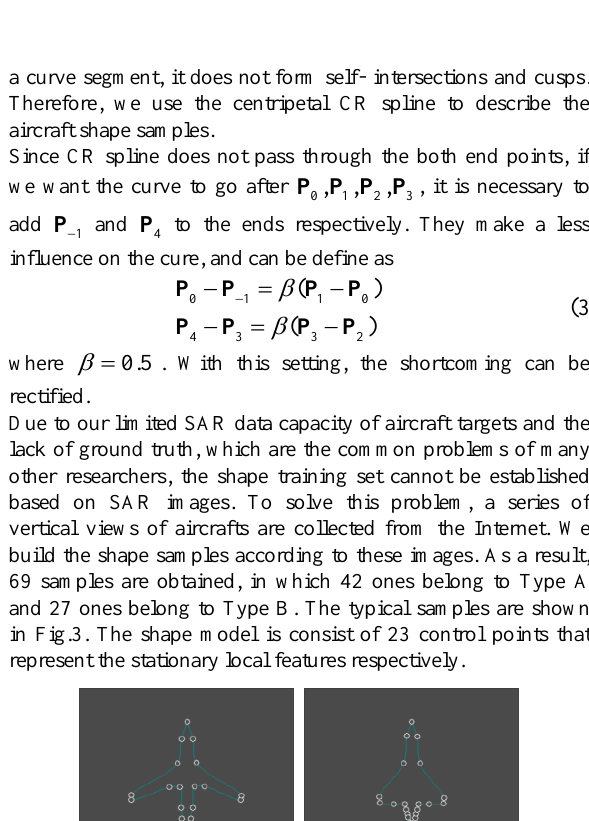
2. ASM BASED ON ISOMAP